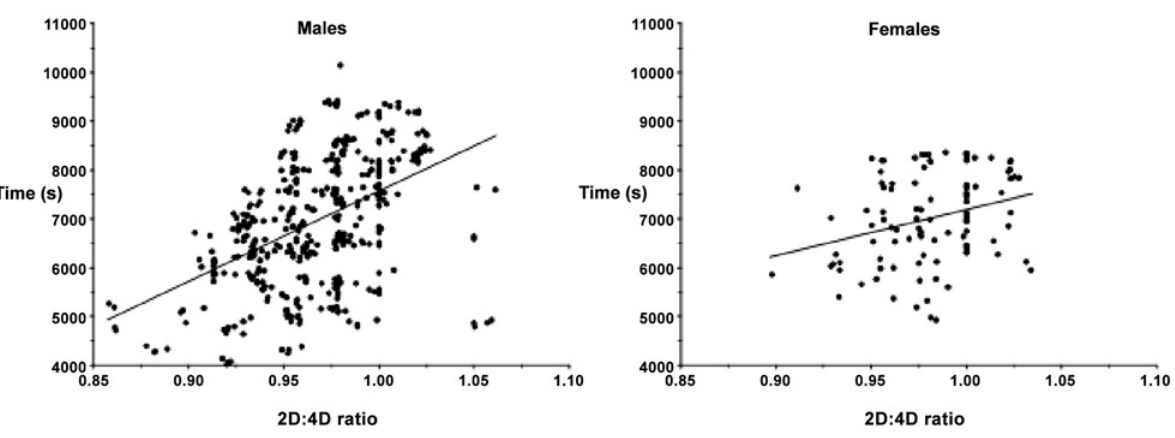
Fig 1. Scatter plot of male and female right hand 2D:4D ratio versus half marathon performance (s). The steeper male gradient is visible.